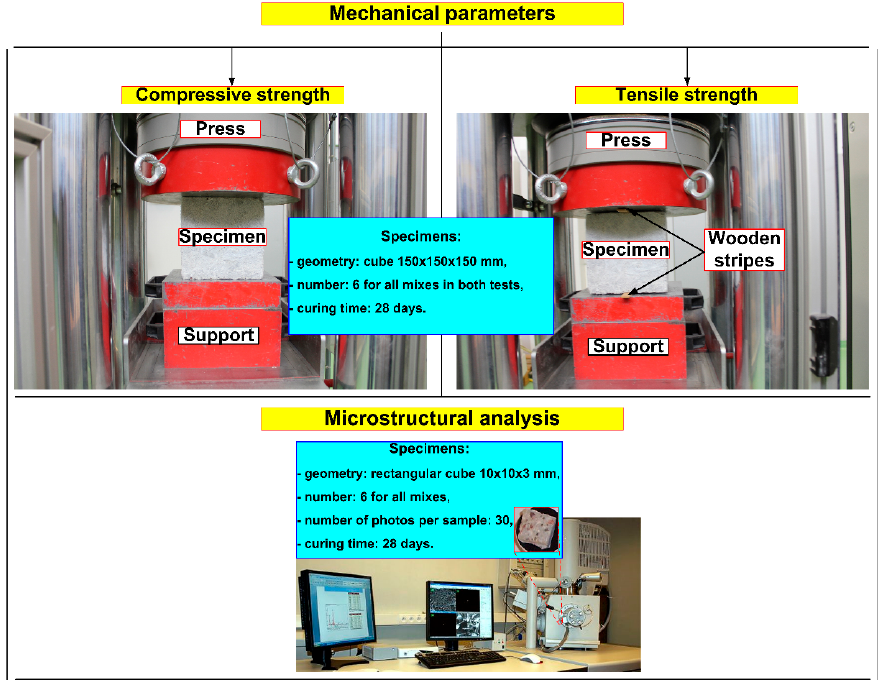
Figure 3. Flowchart of the study.